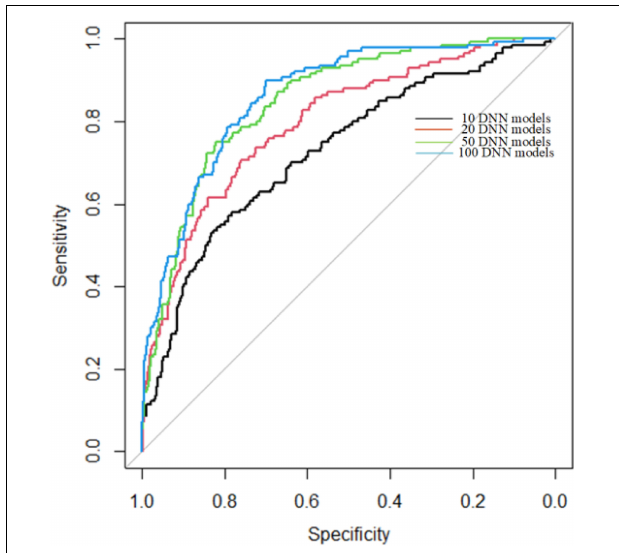
FIGURE 3 | ROC curves of different numbers of DNN